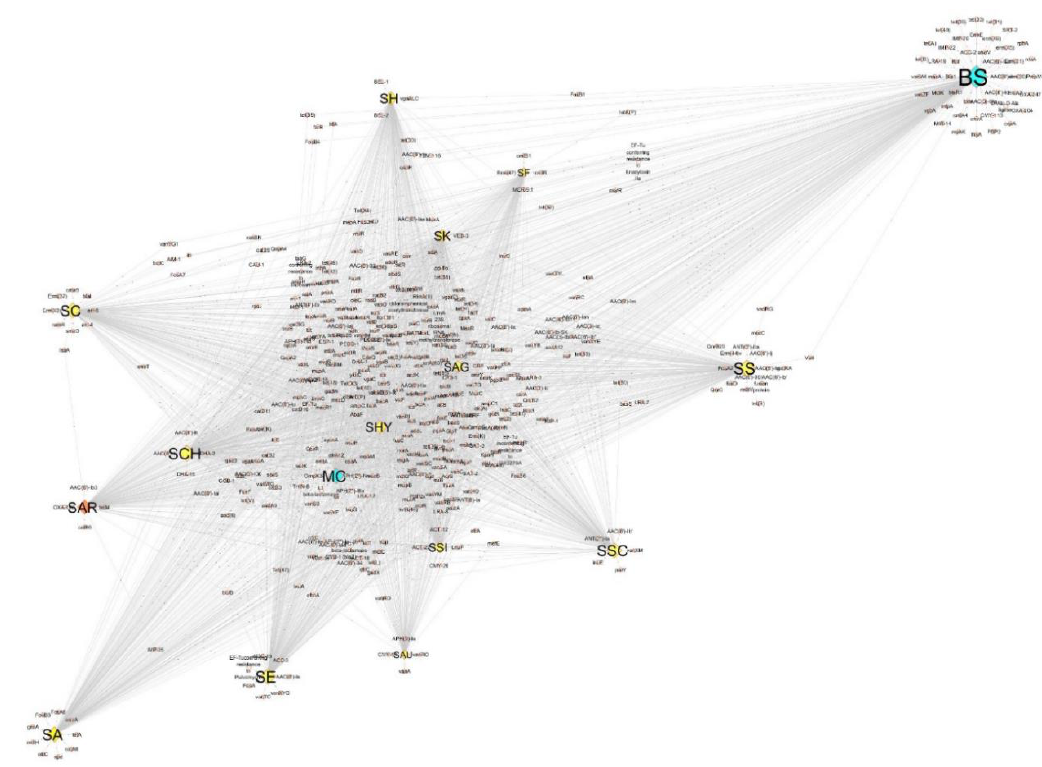
Figure 2. Network of antibiotic resistance determinants shared between all investigated species. Network was built by Cytoscape v. 3.7.2. The distance between species is proportional to the number of unique elements per species and connections among species. Orange diamond, SAR; yellow diamonds, Staphylococcus species (SA, SE, SAU, SSI, SSC, SCH, SC, SHY, SS, SAG, SK, SH, SF); light blue diamonds, outgroup species (BS, MC). The size of each diamond corresponds to the number of antibiotic resistance determinants per species. See Table S4 for details on the molecular elements of antibiotic resistance shared among the species in the dataset. Species abbreviations are in the Material and Methods Section (Section 2.4).